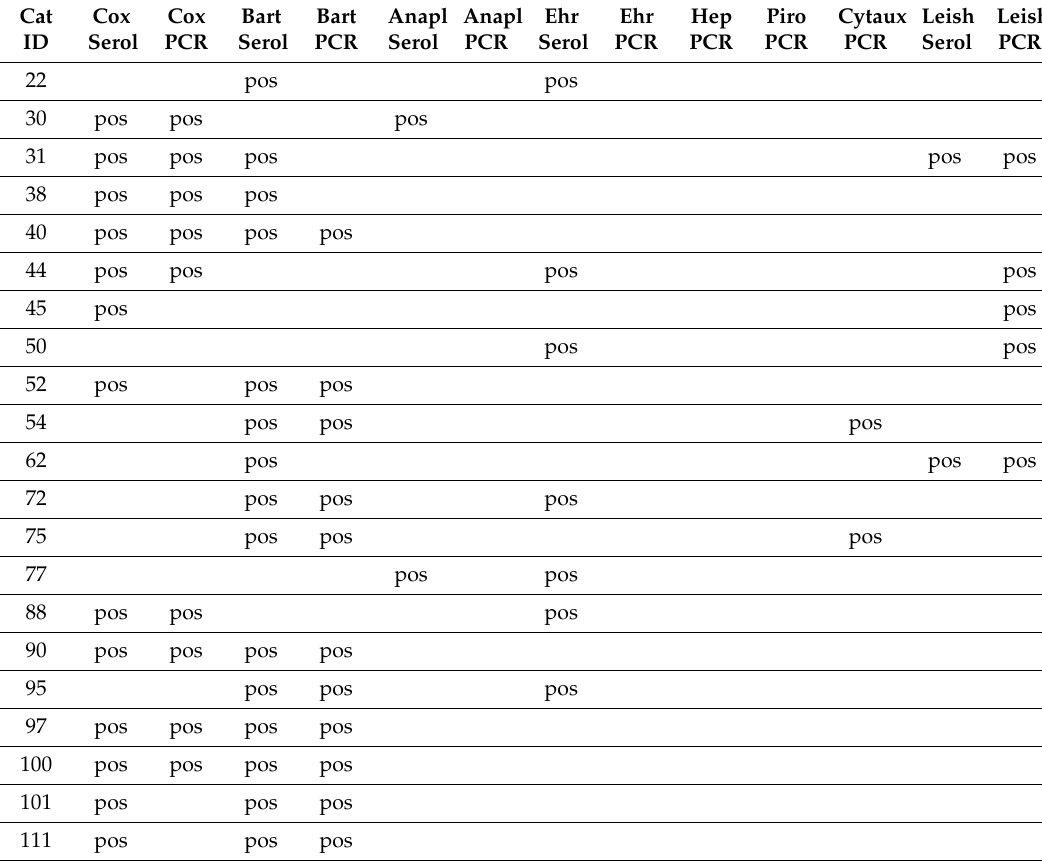
Table 3. Details of the cats with coinfections of two or more pathogens. ID,